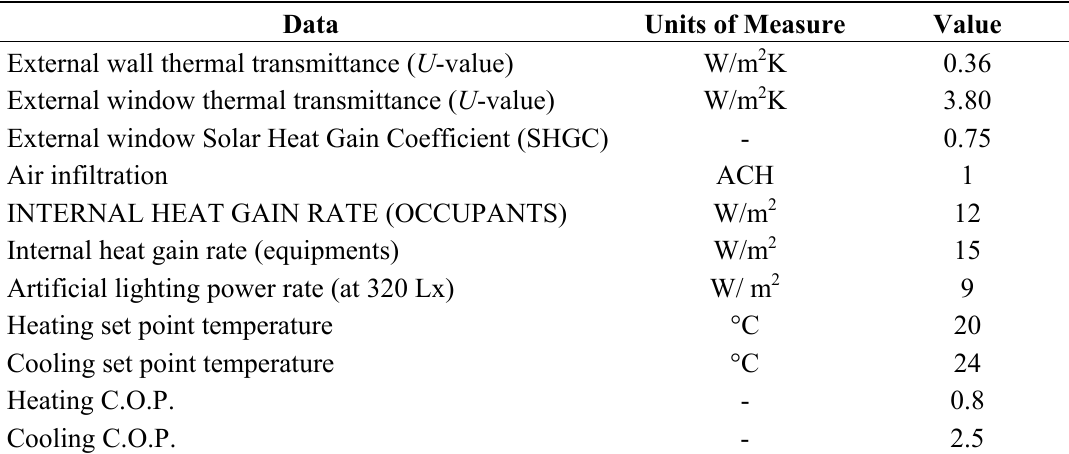
Table 1. Input parameters for thermal dynamic